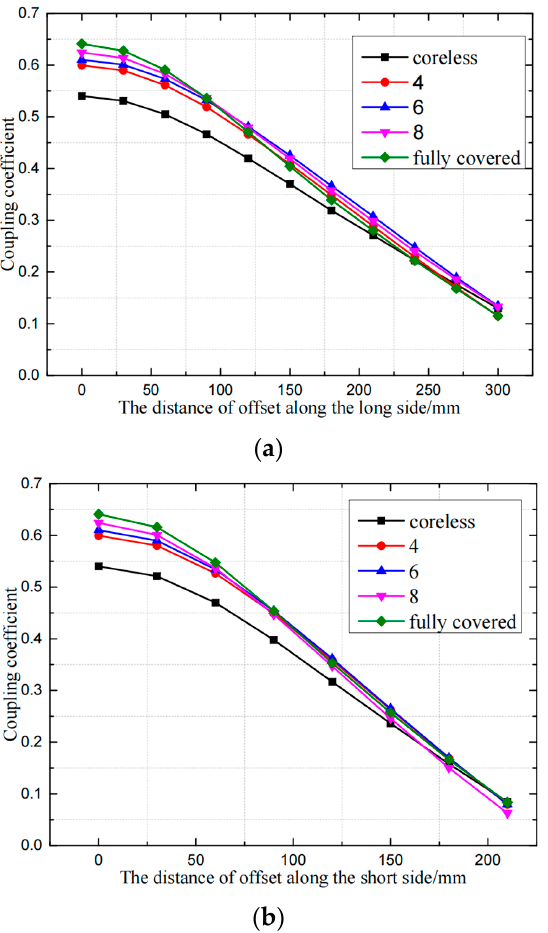
Figure 7. Comparison of anti-offset capabilities of different core distribution: ( a ) offset along the long edge, ( b ) offset along the short edge.